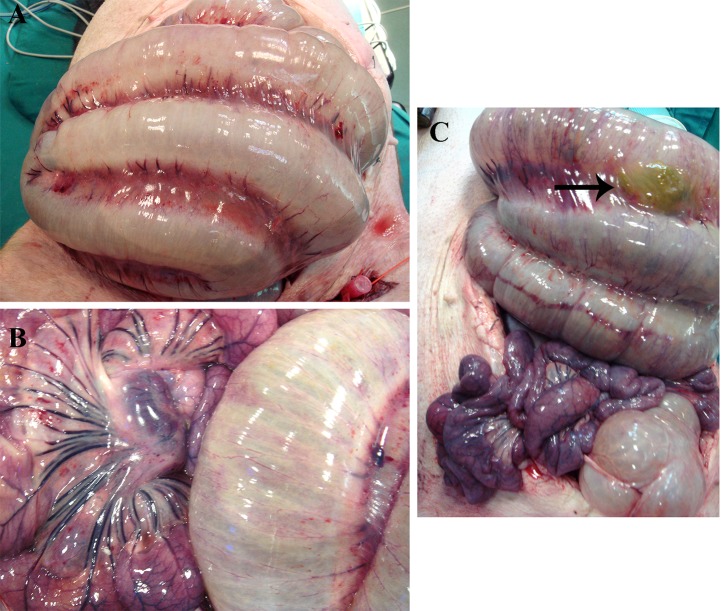
Macroscopic images of colon.(A) Dilated colon with increased intraluminal pressure. (B) Small intestine (left) and colon (right) both with edematous and congestive aspect, most remarkable in small intestine. (C) Perforation (arrow) in dilated colon at the top and congested small intestine at the bottom.